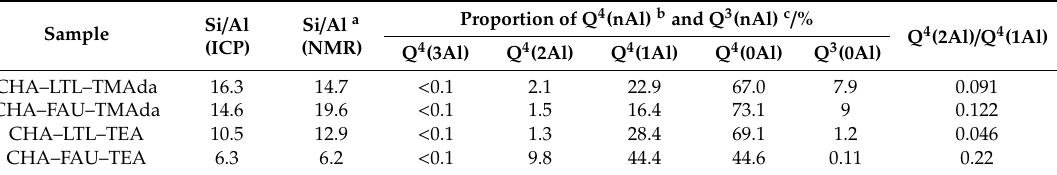
Figure 1. 29 Si MAS NMR spectra with curve fittings of the products: ( a ) CHA–LTL–TMAda, ( b ) CHA–FAU–TMAda, ( c ) CHA–LTL–TEA, ( d ) CHA–FAU–TEA. TEA: Tetraethylammonium cation; TMAda: Trymethyladamantyl ammonium cation. Table 2. 29 Si MAS NMR spectra deconvolution